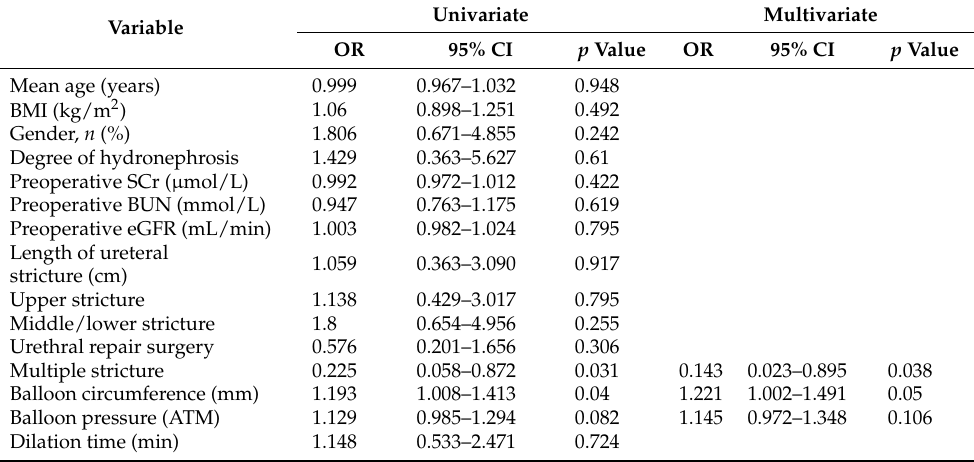
Table 4. Univariate and multivariate logistic regression analysis for failure of balloon